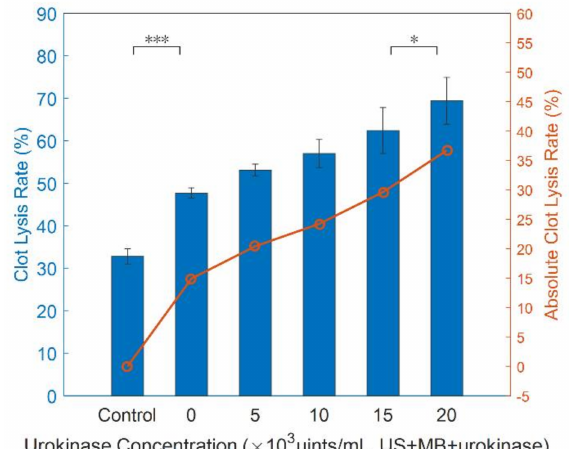
Figure 13. In vitro US + MB + urokinase experiment result. Clot lysis vs. urokinase concentration ( n = 3, US settings of 1.1 MHz, 60 V pp input voltage, 500 Hz PRF, 60 µ g/mL MB in combination with 20,000 units/mL urokinase injected at 2 mL/h, 60 min treatment) (*** p < 0.001, * p <